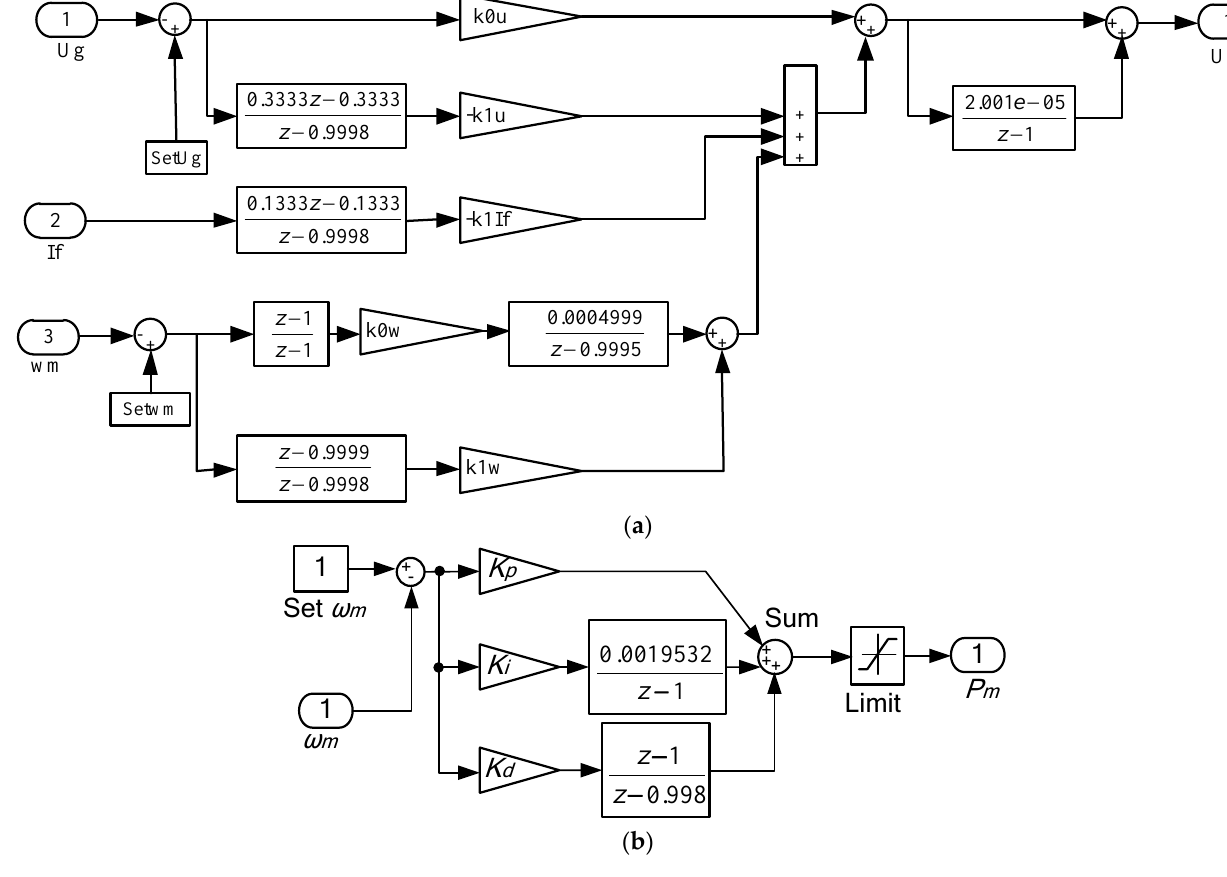
Figure 6. Flow charts of Simulink models of the ARE ( a ) and ARS ( b ) of the experimental setup. Experimental data obtained with the physical model of the turbogenerator, presented